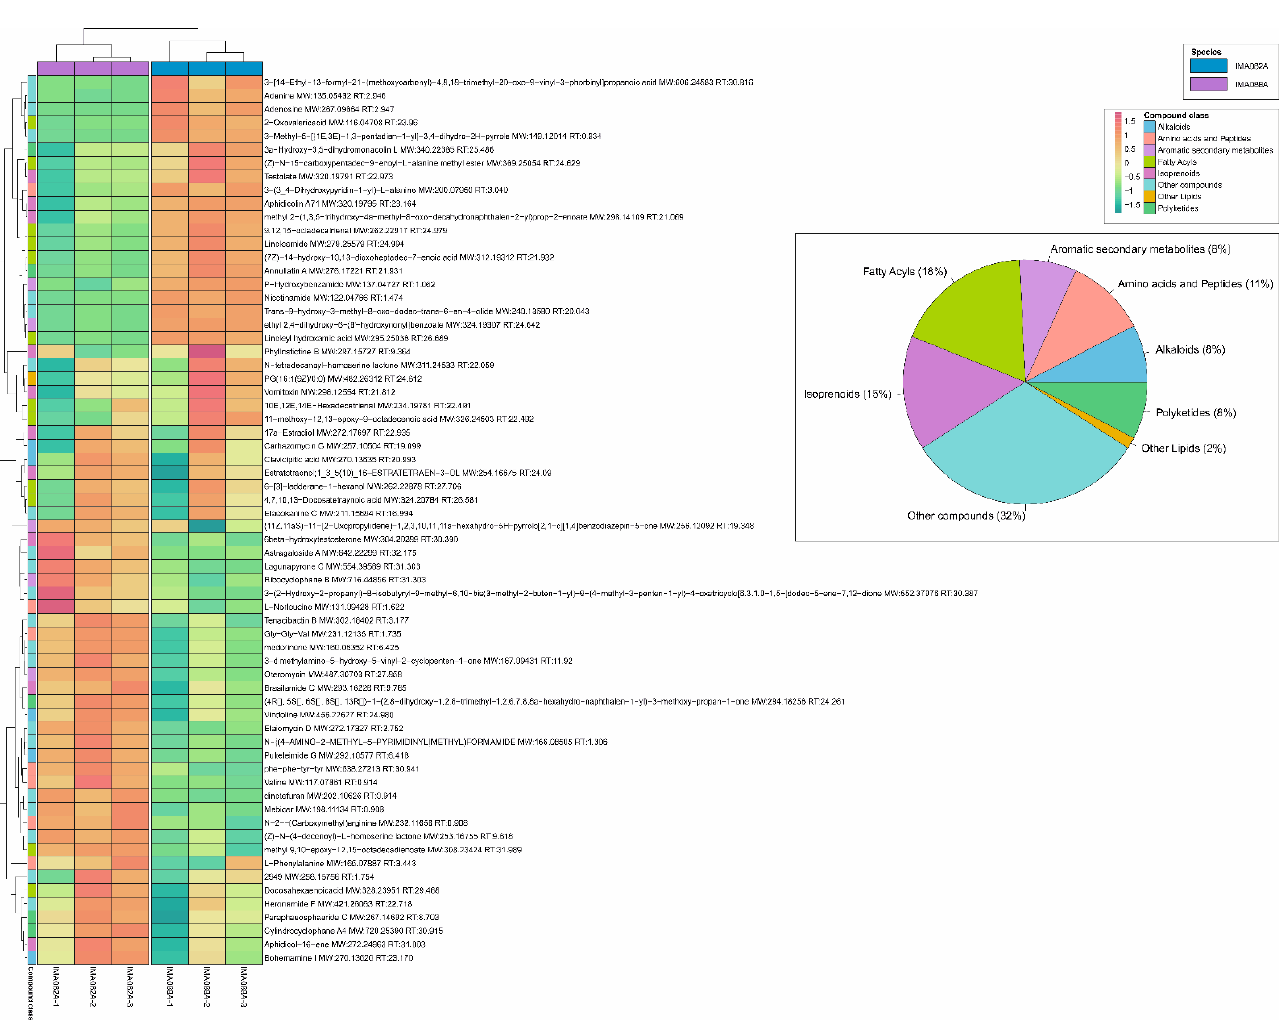
Figure 7. Feature analyses for candidate biomarker selection ( p ‐ values < 0.005). Hierarchical clustering heat map of metabolites between groups in positive ion mode. Colors from red to green indicate the normalized relative abundance values of metabolites from low to high according to the scale bar. Samples of C. ineffabilis IMA082A (blue) and C. zucchellii IMA088A (violet) are disposed in columns; replicates are indicated with suffix numbers 1, 2 and 3. Compound classes are indicated in different colors and percentages of each class are reported on the right side of the figure.